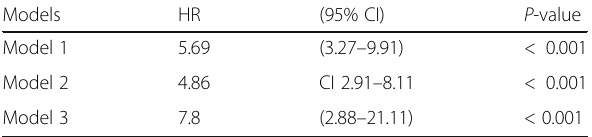
Table 3 Multivariate Cox proportional hazard regression models predicting overall survival, for p-Stat3 percentage adjusting for different confounders Models